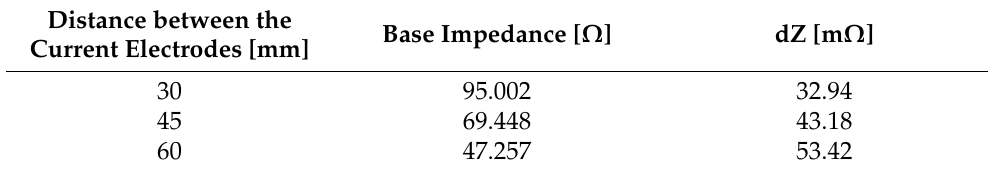
Table 6. The results of bio-impedance measurement on subject.